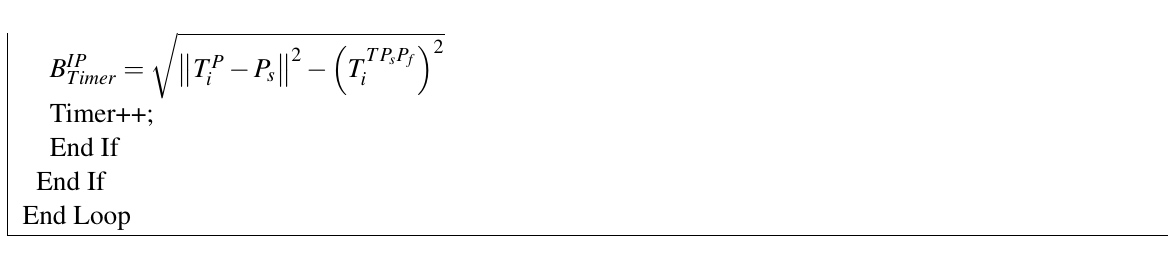
Fig. 3 method of calculating B I